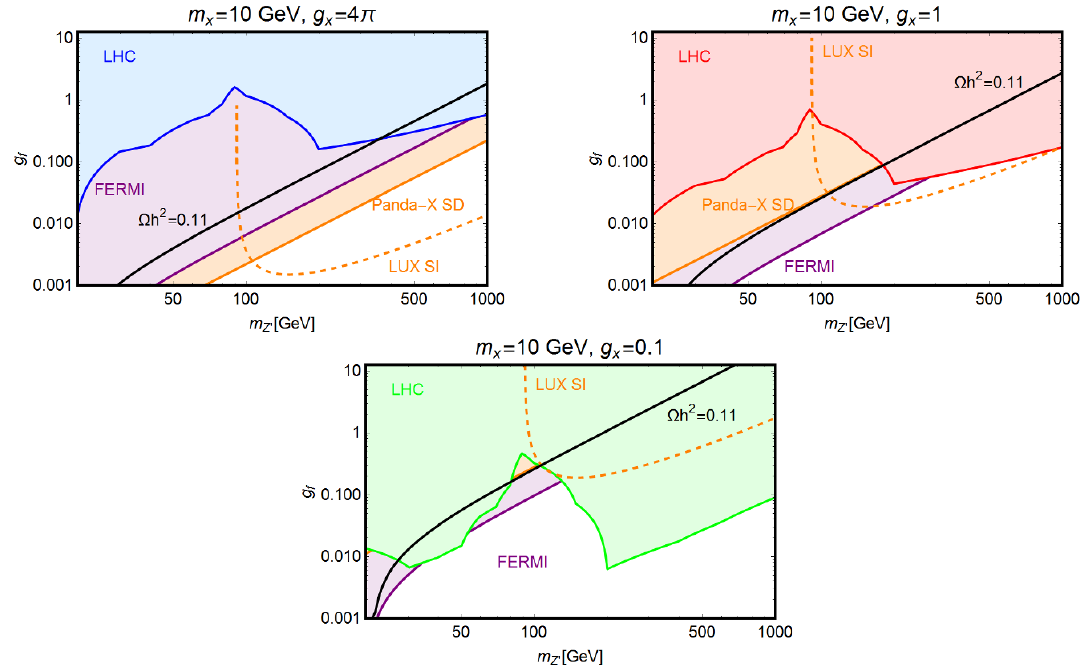
Figure 4 . Results for m (cid:31) = 10 GeV and g (cid:31) = 4 (cid:25); 1 and 0 : 1. Combined upper bounds on the model under study, in the bidimensional plane ( m Z 0 ; g f ) for the assignations of the DM mass m (cid:31) and coupling g (cid:31) reported in the di(cid:11)erent panels. The black lines delimit the correct relic density parameter space. The blue, red and green regions are excluded by LHC data. The orange region represents spin-dependent PANDA-X exclusion region, whereas the dashed curve the spin- independent LUX limit, while in purple FERMI-LAT